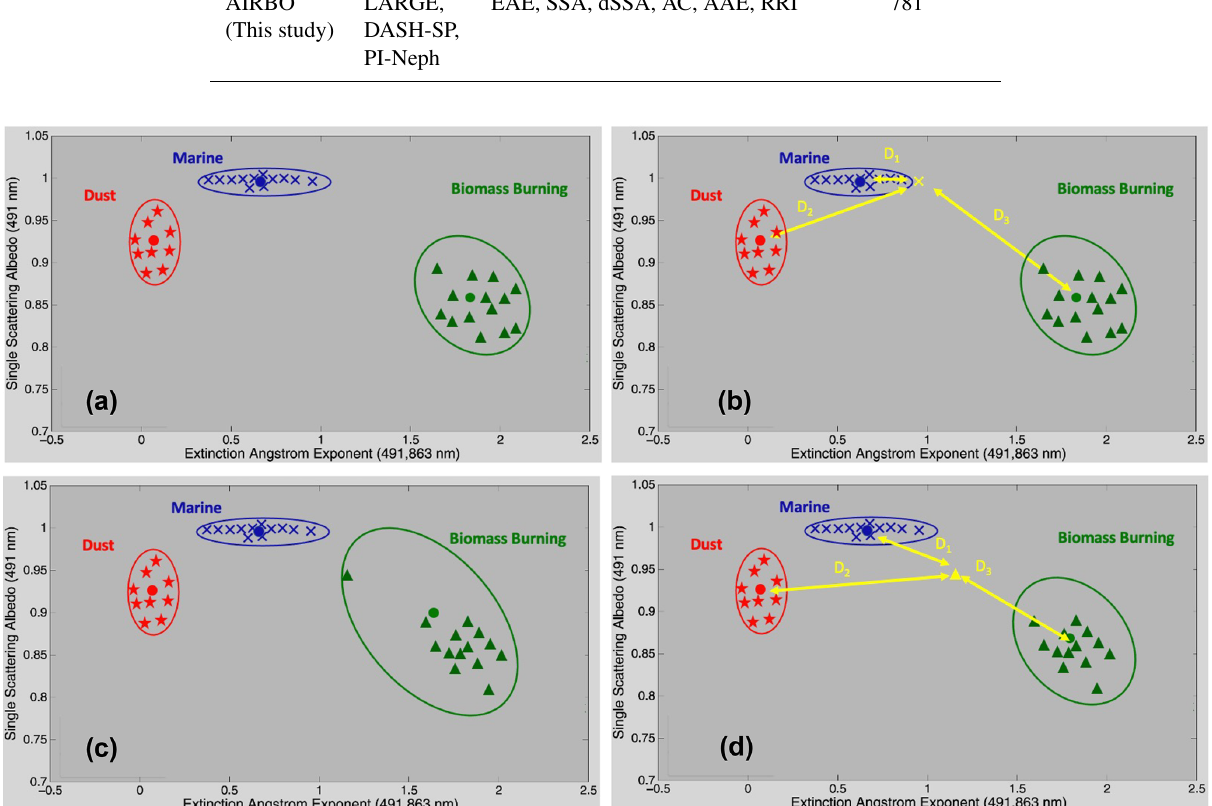
Figure A1. Conceptual/hypothetical illustration of how we quantify separation between different air mass types and select the most useful and well-separated aerosol optical parameters. It shows three hypothetical PS-AMTs (e.g., dust in red, marine in blue and BB in green) measured by one hypothetical optical instrument in one environment (a–b) and in another environment (c–d) . The EAE and SSA values in this illustration are based on AERONET observations (Russell et al., 2014) and are representative of typical pure dust, marine, and BB total column remote-sensing-inferred ground-based EAE and SSA values. Note that it only shows two dimensions even though some calculations of Mahalanobis distances (e.g., D 1 , D 2 , D 3 ) will be made using more dimensions in this